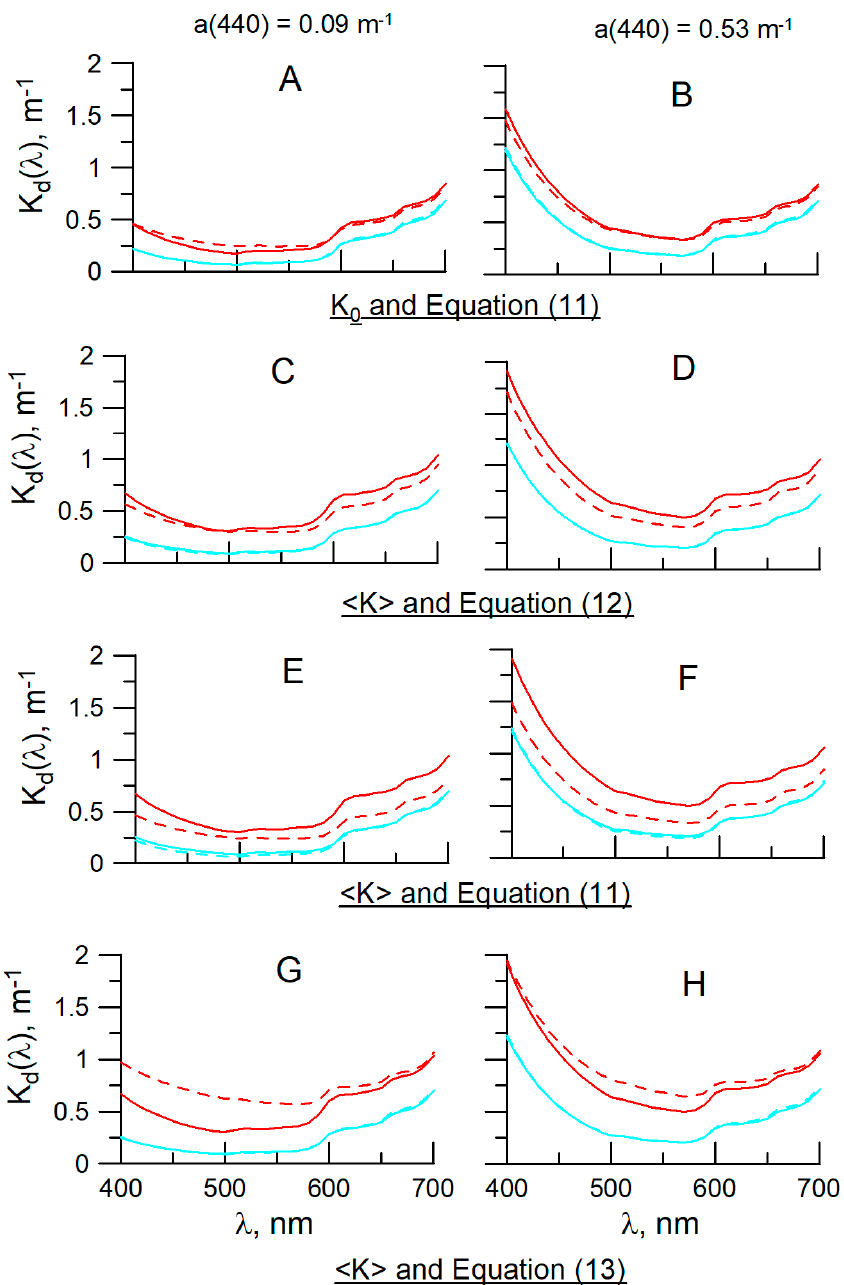
Figure 16. Spectral values of the diffuse attenuation coefficient K d in the Black Sea, θ 0 = 25°, N coc = 10 7 cell/L (red curves) and N coc = 0 (blue curves), a (440) = 0.09 m − 1 (left column) and 0.53 m − 1 (right column). The cases ( A , B ) are calculated for K 0 , the all others for < K >; solid lines, by numerical calculations; dashed lines, with the approximated Equations; ( A,B ) and ( E , F) , Equation (11), ( C , D ), Equation (12), ( G , H) , Equation (13).